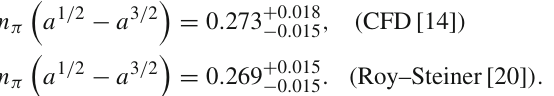
Fig. 12 The continuous line is our final CFD parameterization of the ( t ) from the Brookhaven-II analysis [9]. The data on the modulus of ˆ g 0 2 gray band stands for the uncertainty from the CFD parameters.The dashed line is the UFD parameterization. The difference between the UFD and CFD parameterization near threshold is imperceptible due to the q 5